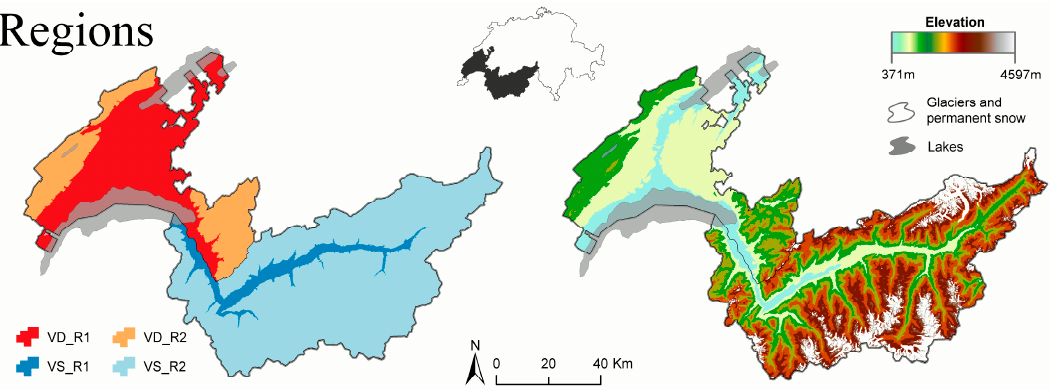
Figure 1. Study area and modelled regions: canton of Vaud bellow 900 m a.s.l. (VD_R1), canton of Vaud above 900 m a.s.l. (VD_R2), canton of Valais bellow 900 m a.s.l. (VS_R1) and canton of Valais above 900 m a.s.l. (VS_R2).